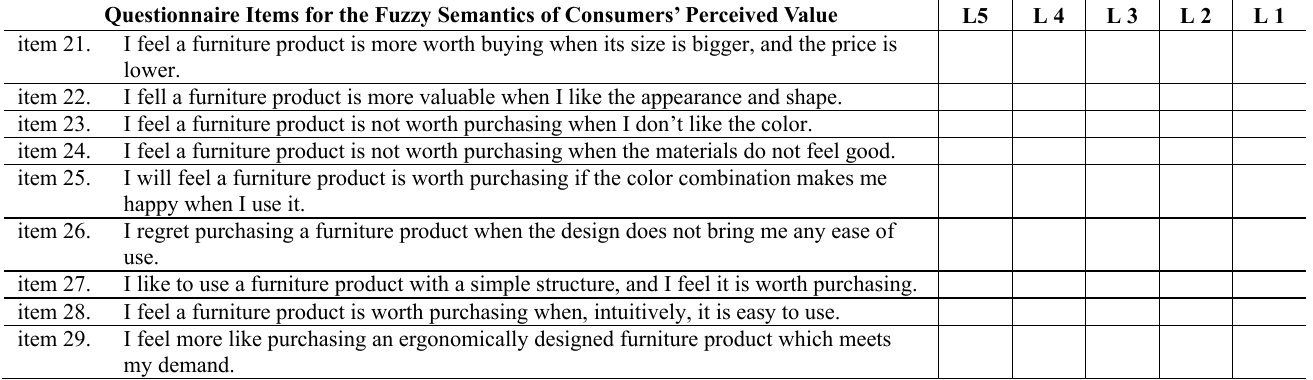
Table 2: The evaluation items for the fuzzy semantics of the consumers’ perceived value based on your actual experience in purchasing and actually using a furniture